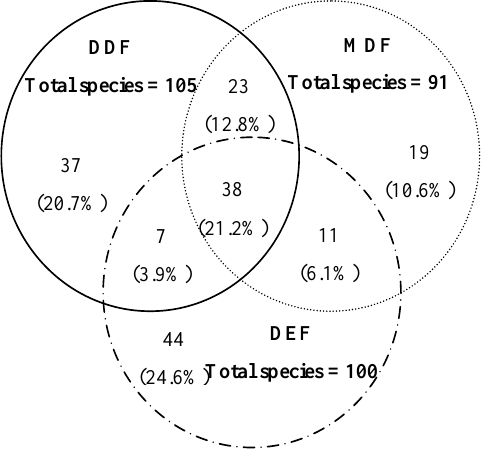
Figure 3. The numbers of tree species in the predominant land-cover types in Savannakhet.